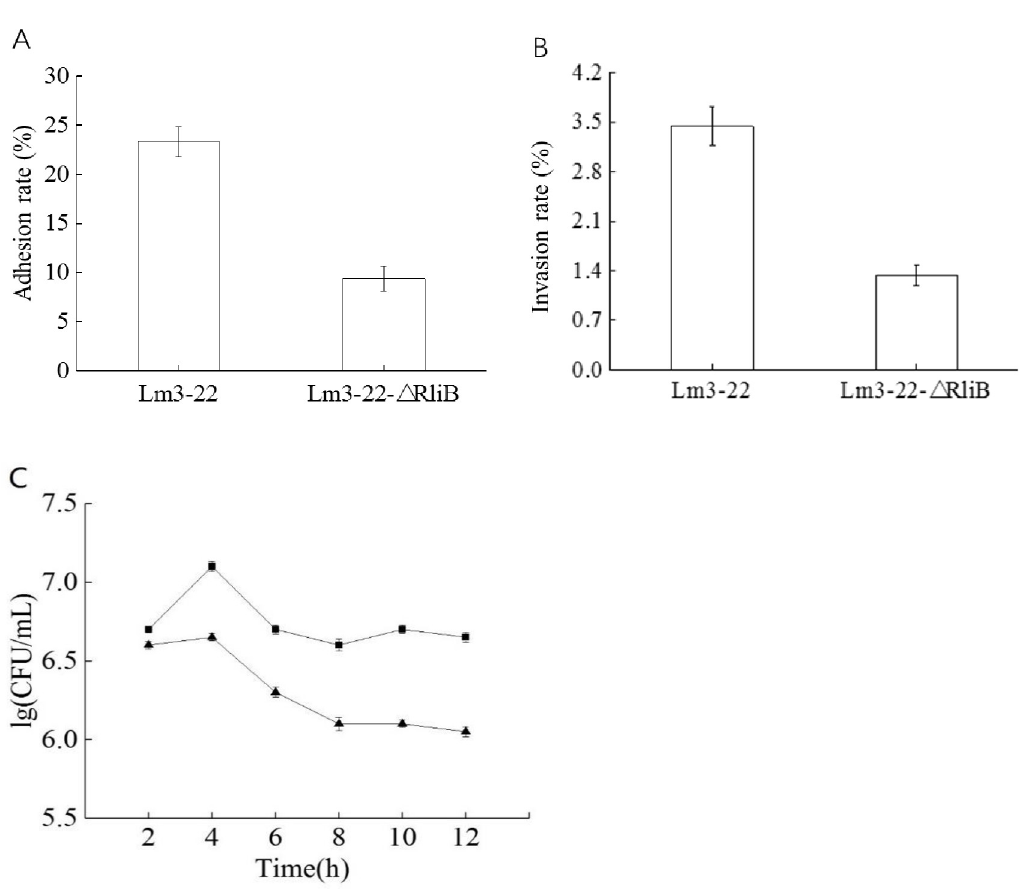
Fig 4. Cell adhesion, invasion, and intracellular proliferation ability of rliB deficient L . monocytogenes . The number of wild- type Lm3-22 ( ) and rliB deficient Lm3-22- Δ rliB ( ) in RAW264.7 cells at various times after infection. Adhesion (A), invasion (B), and intracellular proliferation (C) were evaluated in the mouse macrophage cell line RAW264.7. The experiments were repeated three times, each time in triplicate wells for Lm3-22 and Lm3-22- Δ rliB, respectively. Values correspond to the mean from three independent